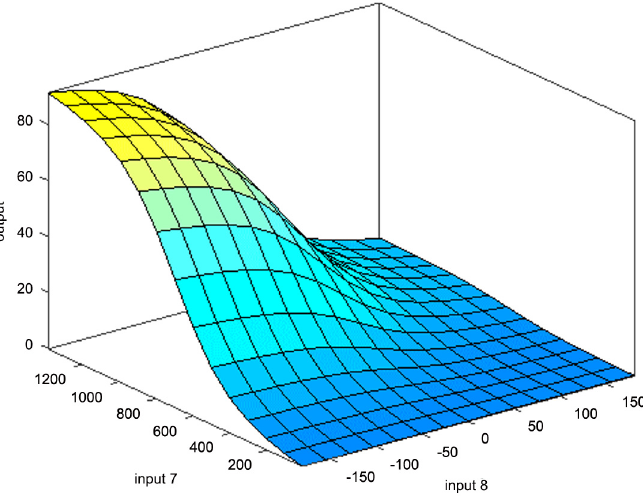
Fig 3. ANFIS decision surfaces for vehicle agent speed relative to vehicle intruder prediction for two selected parameters 7 (Distance between vehicles) and 8 (Relative Angle between vehicles).